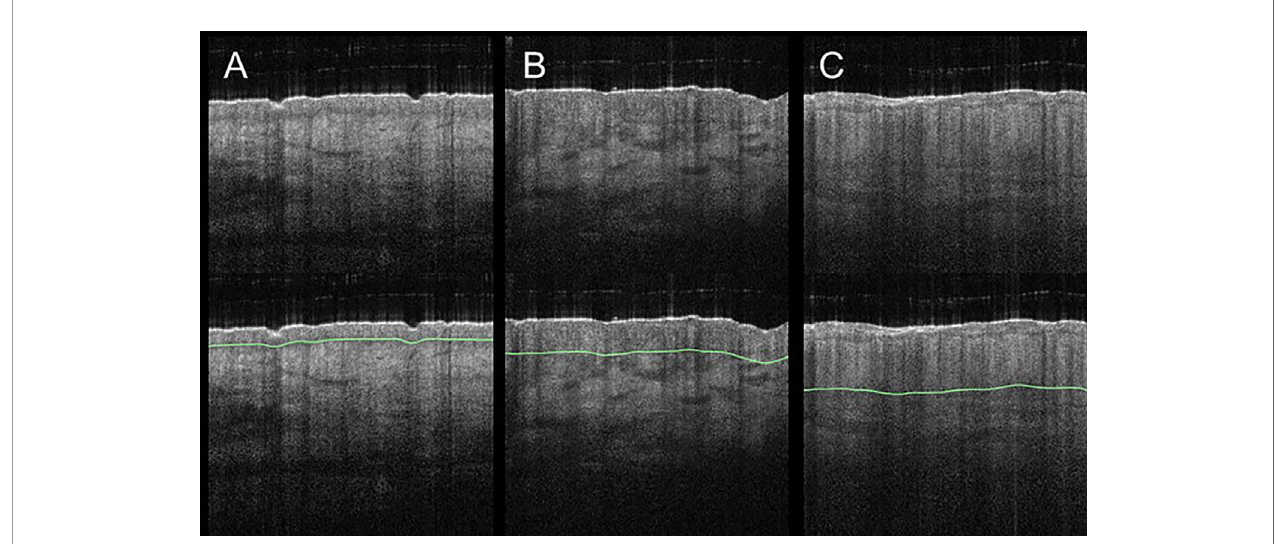
FIGURE 8 | Acute and chronic in fl ammatory skin diseases can lead to an increase of the epidermal layer. Compared to healthy skin (A) , involved skin in atopic dermatitis (B) and in plaque psoriasis (C) exhibit a thicker epidermal layer. Changes of epidermal thickness (green line) can be visualized in vertical B-scans and measured by OCT.